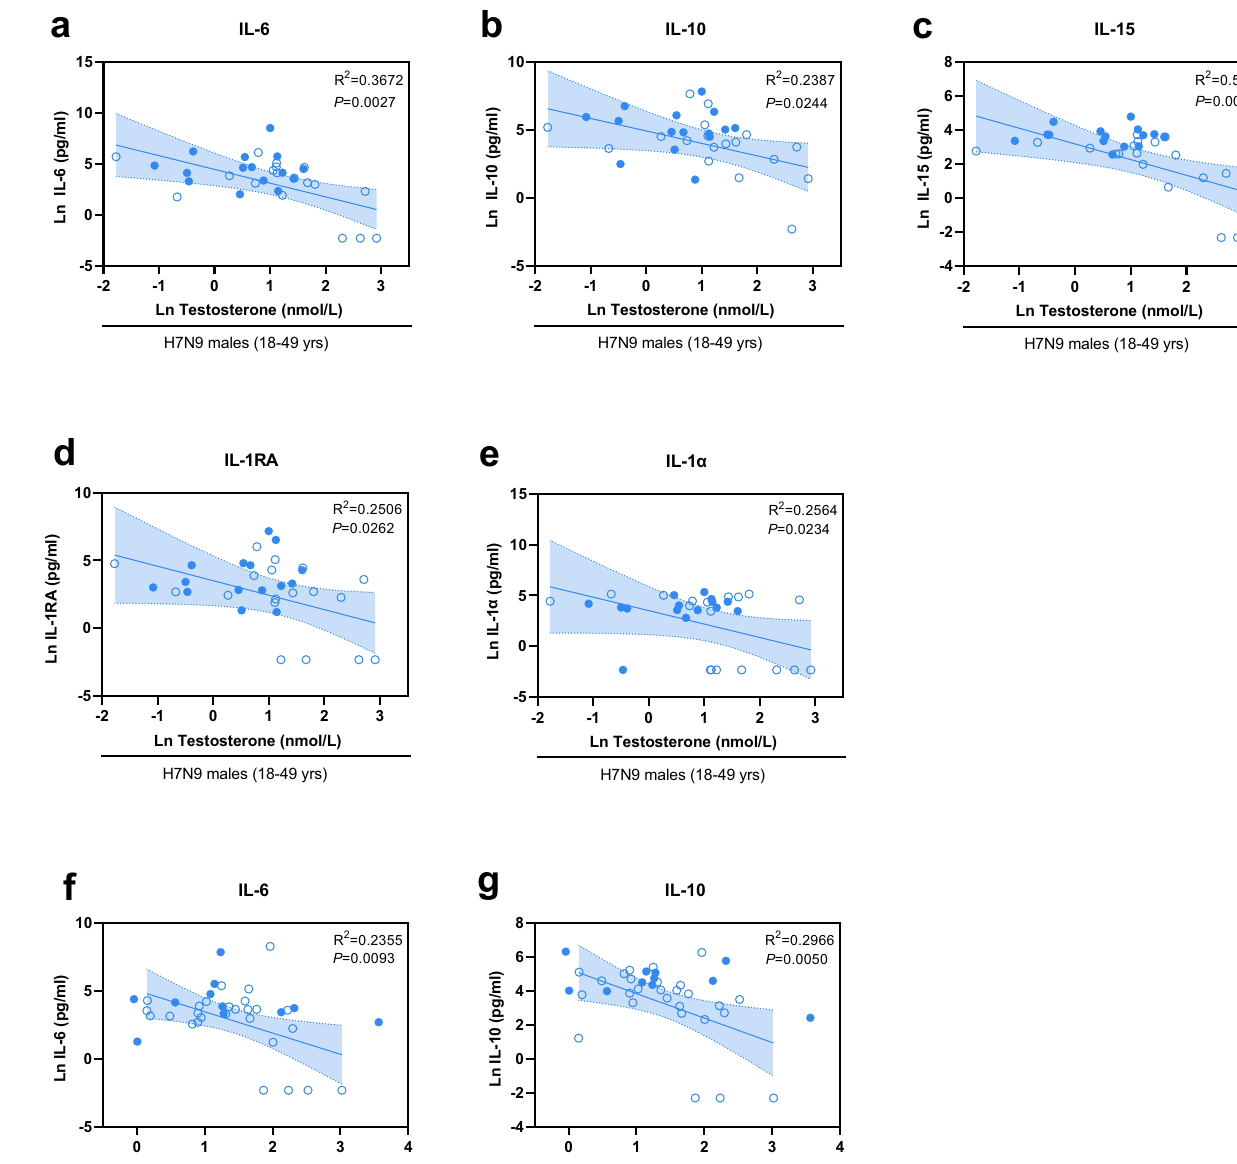
n =18/15); f , g Observed overall regression of testosterone with cytokines IL-6 (interleukin 6; f ) and IL-10 (interleukin 10; g ) in H7N9 older males without inter- action between deaths and survivors ( ≥ 50yrs survival/death: n =27/11). a – g The best- fi tlinewith95%con fi denceintervalsoftheoverallregressionisshownineach fi gure. The centre of the error distribution is the regression line. Two-tailed linear regression was performed. Adjustment for multiple hypotheses was not necessary due to the explorative natureofthe study.A hollowblue circlerepresentssurvival, and a solid blue circlerepresents death. R squared values are shown in the fi gures. Source data are provided as a Source data fi